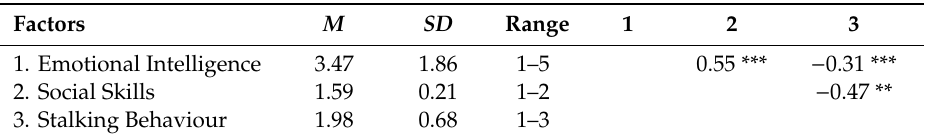
Table 2. Descriptive statistics and Pearson’s